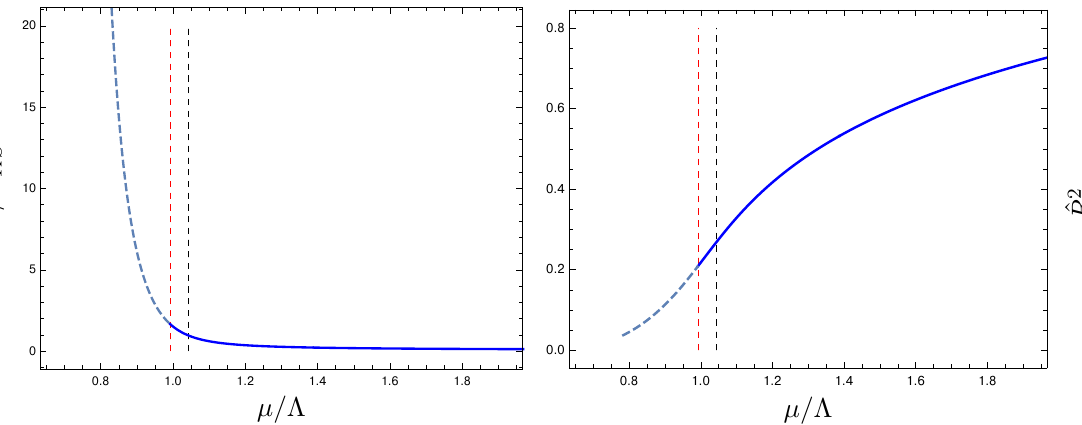
s Figure 8 . Left panel: the reduced Kretschmann scalar ˆ of vacua in the deep IR of the bulk A K V geometry, see (5.7). ˆ denotes the value of the scalar for the Klebanov-Strassler solution, i.e., K KS when µ/ Λ = 0, see (5.8). Right panel: the rapid growth of the scalar when µ . µ u (denoted by the vertical dashed red line) is caused by the collapsing of the deformed T 1 , 1 , see (5.11) and